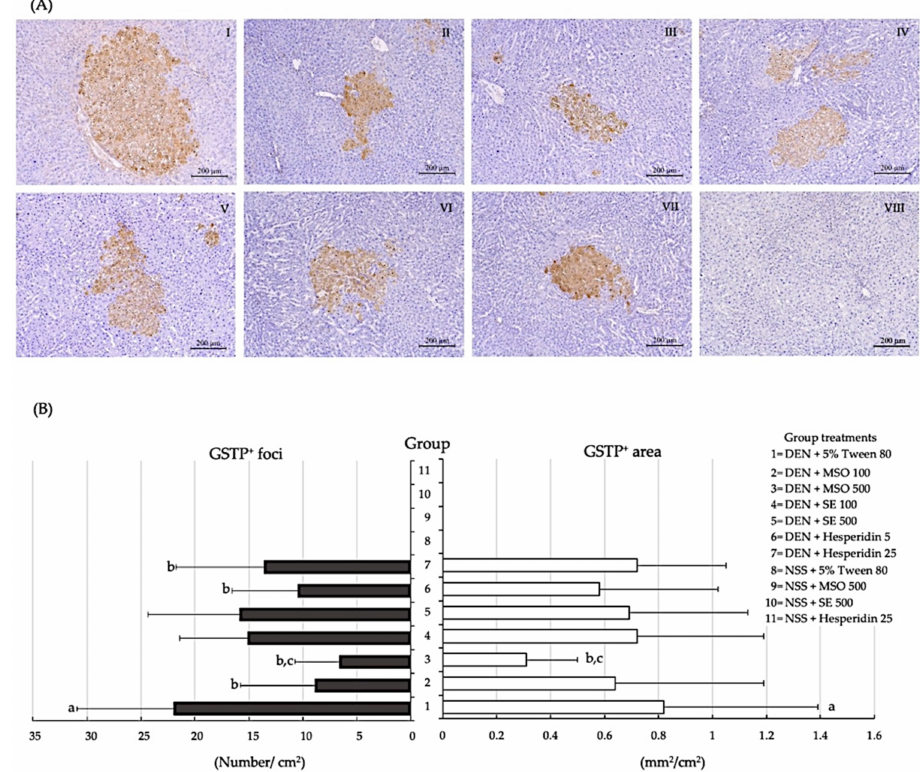
Figure 4. Effect of a 10-week administration of MSO and its compositions on the formation of GST-P- positive foci in rats. ( A ) Characteristics of hepatic GST-P-positive foci, Groups 1–8 are represented as I-VIII, respectively. DEN alone [I], DEN+MSO 100 [II], DEN+MSO 500 [III], DEN+SE 100 [IV], DEN+SE 500 [V], DEN+Hesperidin 5 [VI], DEN+Hesperidin 25 [VII] and a vehicle control [VIII]. ( B ) Number and area of GST-P-positive foci in rats. Values are expressed as mean ± SD. DEN: diethylnitrosamine; GST-P: glutathione S -transferase placental form; MSO: mixed sesame and orange seed extract; NSS: normal saline solution; SE: sesame extract. a significantly different from a negative control group, group 8 ( p < 0.05). b significantly different from a positive control group, group 1 ( p < 0.05). c significantly different from group 7 (DEN + Hesperidin 25) ( p <